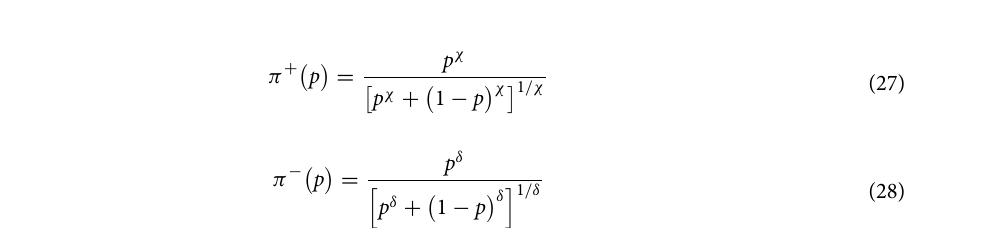
Table 1. Gray emergency decision matrix of each rule